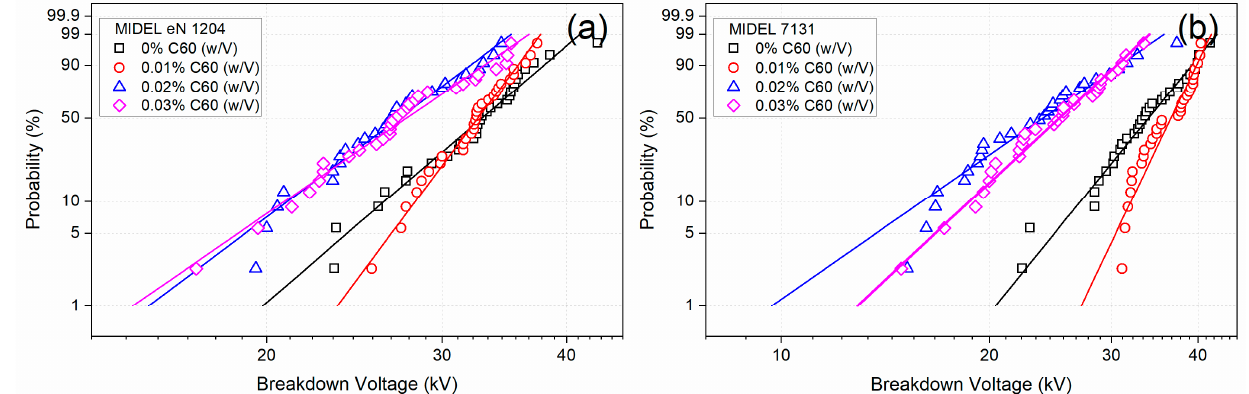
Table 4. Test of conformity to Weibull distribution of executed samples.